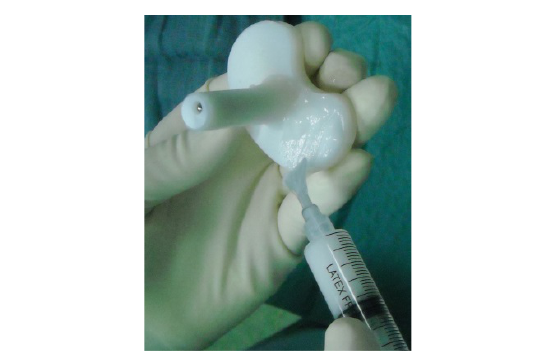
Figure 3. The antibiotic-loaded hydrogel coating is spread onto a stem (A) and an acetabular cup (B and C), which may then be applied directly on the bone in the usual way (D). More hydrogel can be spread on the extra-medullary part of the implant (E).